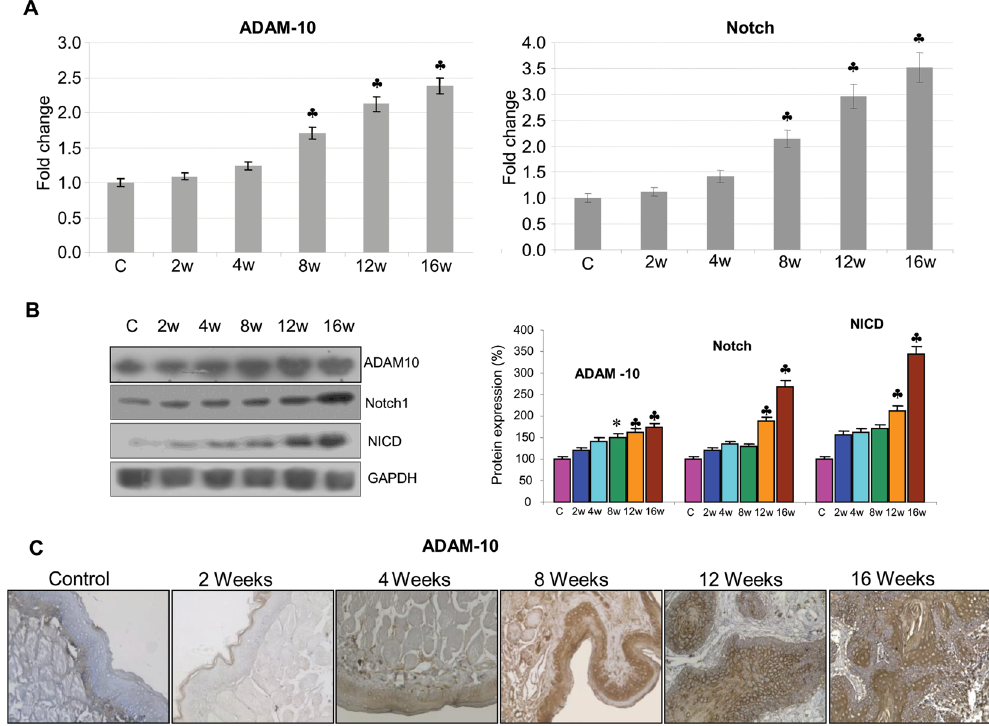
Figure 2. RECK downregulation activates Notch signalling. ( A ) qPCR analysis suggests that ADAM-10 and Notch are upregulated during sequential progression of cancer. Data are the mean ± SD of three independent experiments (N = 3). ♣ p < 0.001, * p < 0.01, # p < 0.05 versus control. ( B ) Protein samples were resolved on SDS- PAGE and western blot analysis was performed using antibodies against ADAM-10, Notch and NICD. GAPDH was used as loading control. Data are the mean ± SD of three independent experiments (N = 3). ♣ p < 0.001, * p < 0.01, # p < 0.05 versus control. ( C ) Immunohistochemical staining of ADAM-10. Images are shown in 20X